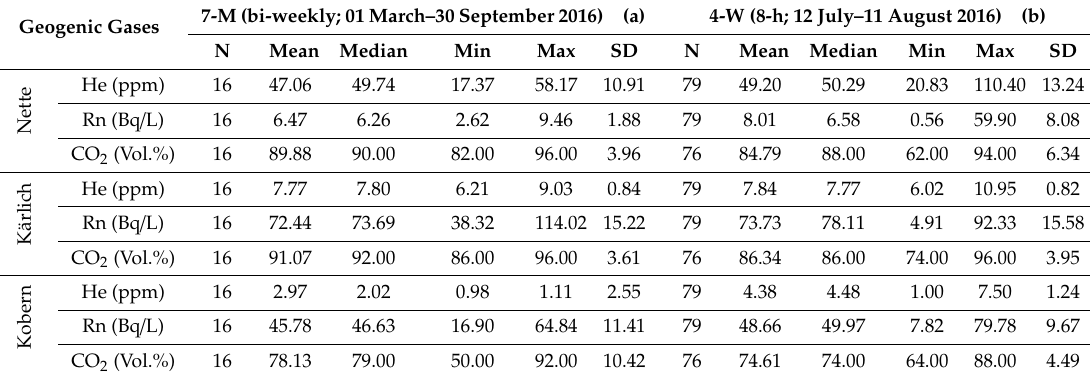
Table 4. Statistics of gas concentrations in the mineral waters for the (a) bi-weekly and (b) augmented 8-hourly samples.